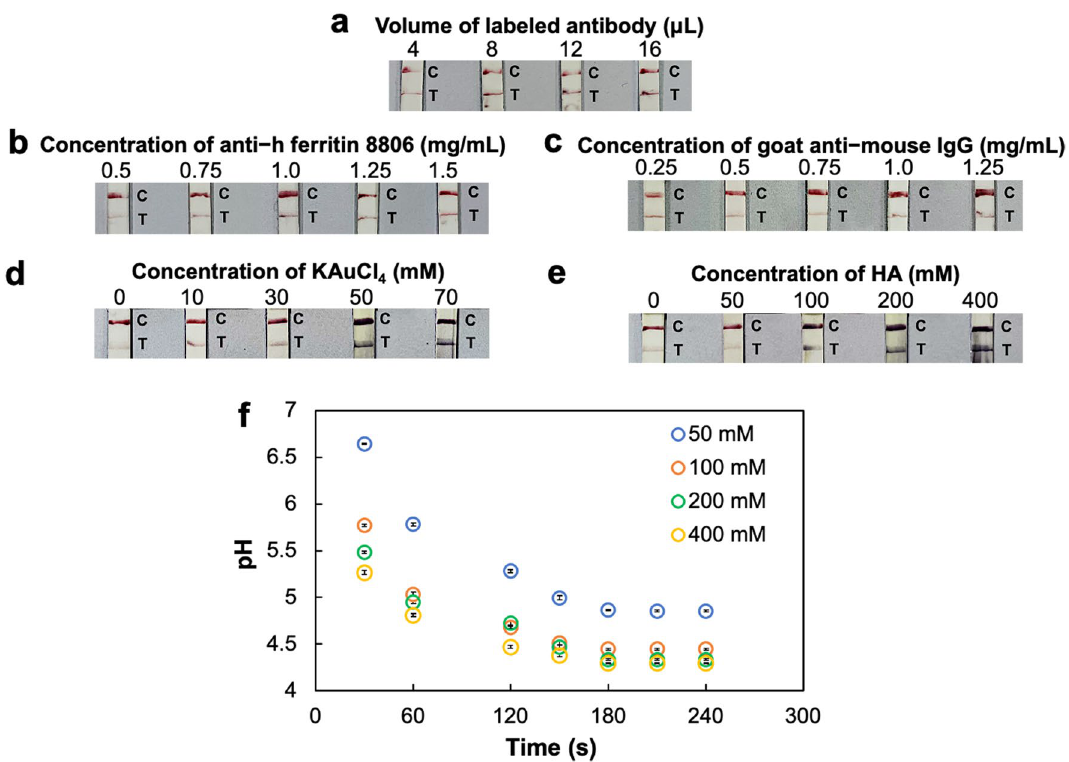
Figure 2. Optimization of parameters influencing the overall device performance: ( a ) effect of the volume of the labeled antibody deposited on conjugate pads (4–16 µL) on assays with 50 ng/mL ferritin samples; ( b ) effect of the concentration of anti-h ferritin 8806 (0.5–1.5 mg/mL) on the T line; ( c ) effect of the concentration of GAM (0.25–1.25 mg/mL) on the C line; ( d ) effect of the concentration of KAuCl 4 (0–70 mM); ( e ) effect of the concentration of HA (0–400 mM) on assays with 20 ng/mL ferritin samples; ( f ) time-dependent solution pH decrease with HA/PVA/PEO blend films with various concentrations of HA (50–400 mM) soaked in water (n =